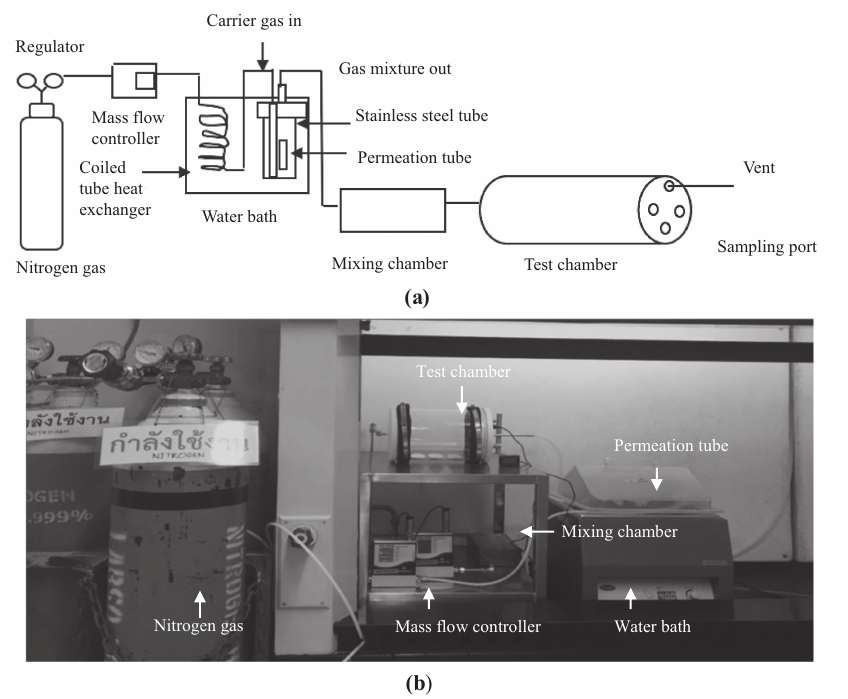
Figure 1. Schematic diagram ( a ) and picture ( b ) of the generation system